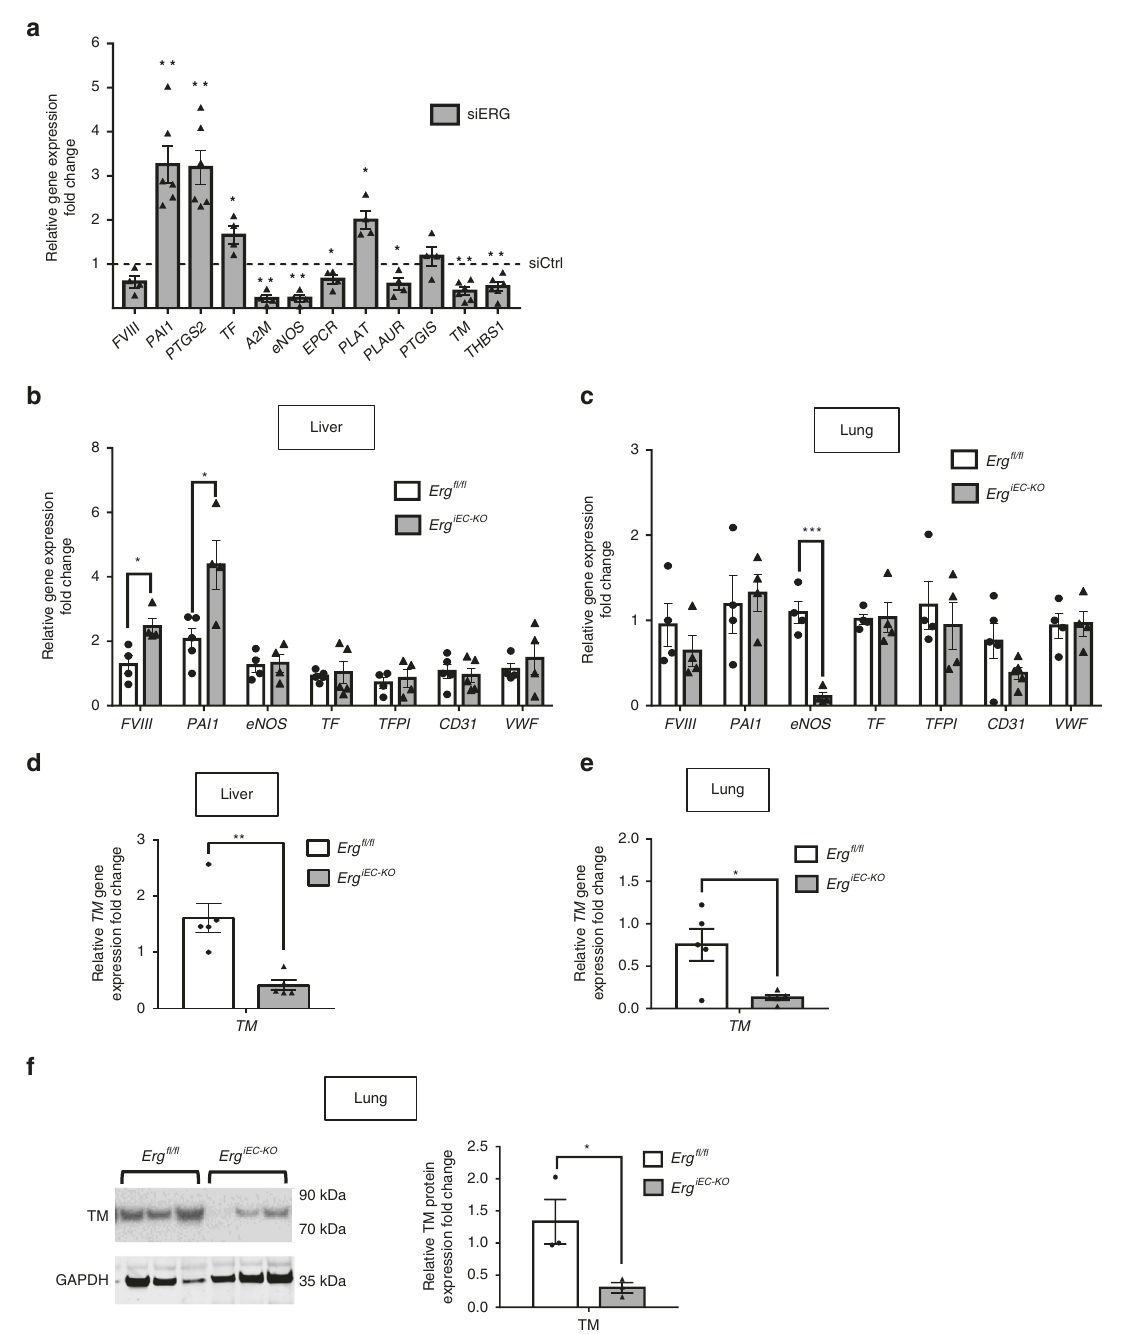
Fig. 2 ERG controls the expression of multiple regulators of coagulation in a tissue-speci fi c manner. a qPCR screen analysis of genes involved in the regulation of coagulation in HUVEC was performed at 48 h after ERG inhibition by siRNA ( n = 4 – 6 independent experiments). Data were normalised to GAPDH . b , c qPCR analysis of selected targets genes directly or indirectly involved in coagulation and endothelial markers in whole liver ( b ) and lung ( c ) lysates from adult control ( Erg fl / fl ) and ERG-de fi cient ( Erg iEC-KO ) mice ( n = 4 – 5 per genotype). Data were normalised to 18S . d – e qPCR analysis of thrombomodulin ( TM) mRNA expression in whole liver ( d ) and lung ( e ) lysates from adult Erg fl / fl and Erg iEC-KO mice ( n = 5 per genotype). Data were normalised to 18S. f Immunoblot and quanti fi cation of WB for TM in protein extracts of lung samples from adult Erg fl / fl and Erg iEC-KO mice 30 days after tamoxifen injection ( n = 3 mice per group). Data were normalized to GAPDH. All graphical data are mean ± s.e.m, * P < 0.05, Student ’ s t -test. Source data are provided as a Source Data fi